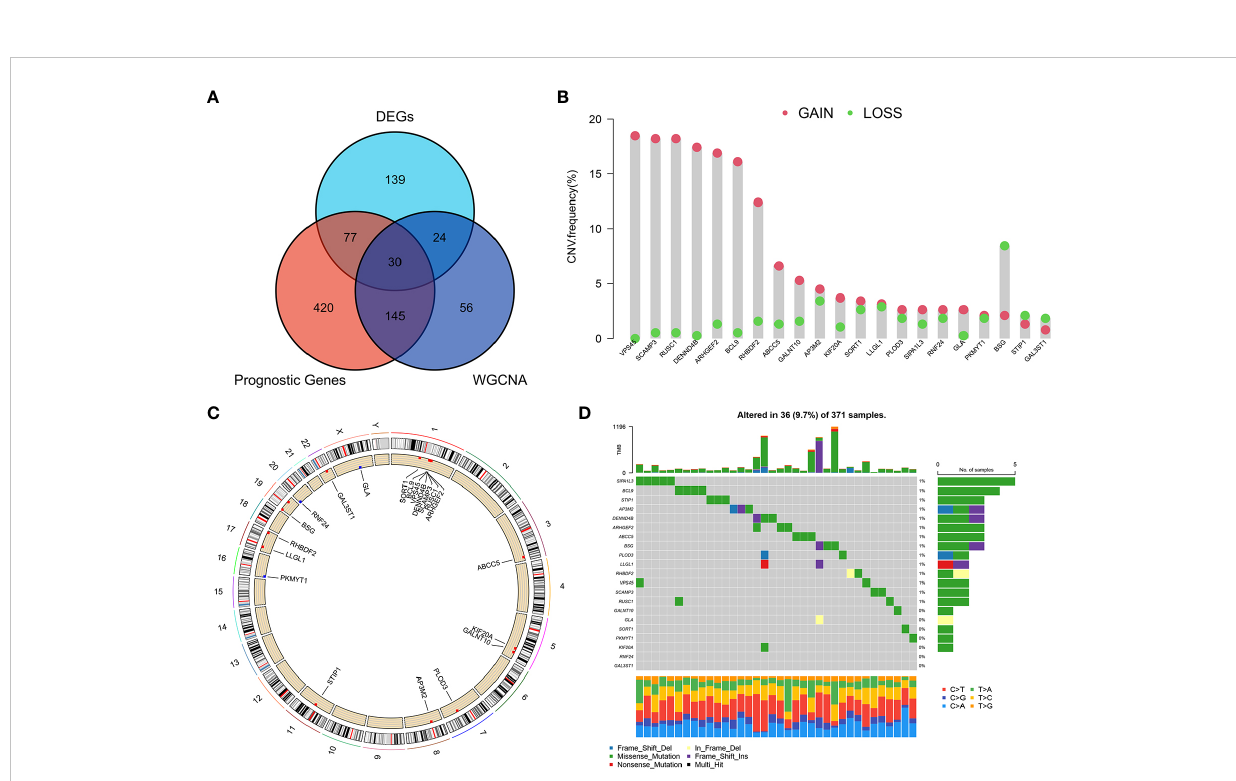
FIGURE 3 Screening of major GARGs and their Copy Number Variation and Mutations. (A) DEGs, prognostic genes and Meblue module genes were intersected by a Venn diagram. (B) The CNV variation frequency of GARGs in TCGA-LIHC. (C) The location of CNV alteration of GARGs on 23 chromosomes in TCGA-LIHC. (D) Mutation frequency of GARGs in